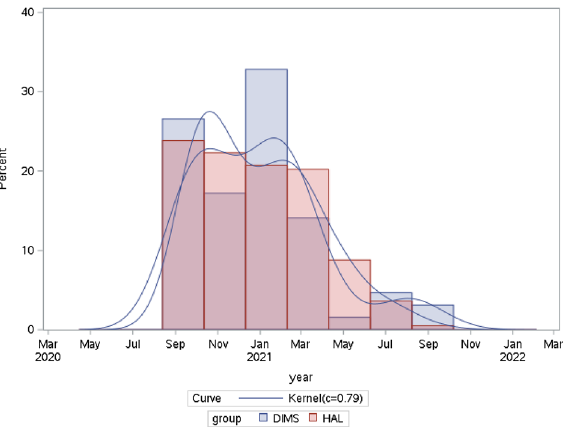
Figure 1. Distributions of baseline prescription dates in the two groups. DIMS defocus incorporated multiple segments, HAL highly aspherical